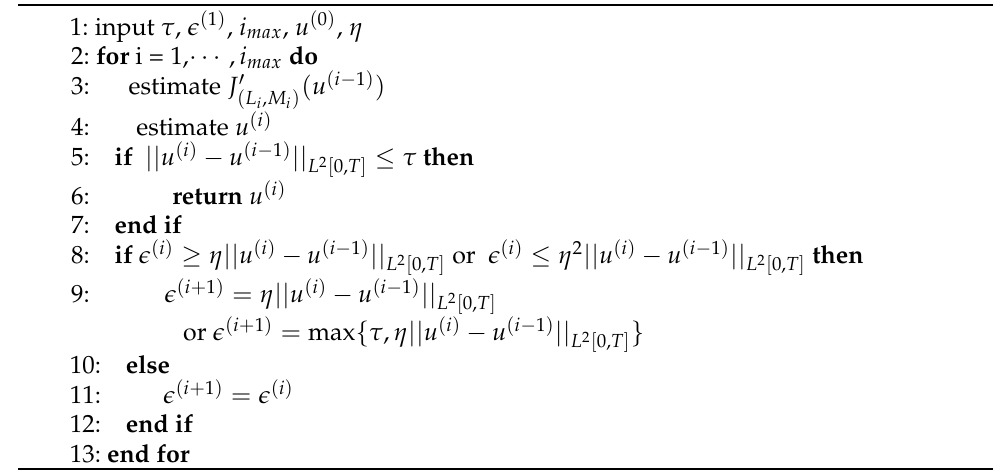
Algorithm 1: MLMC gradient projection based